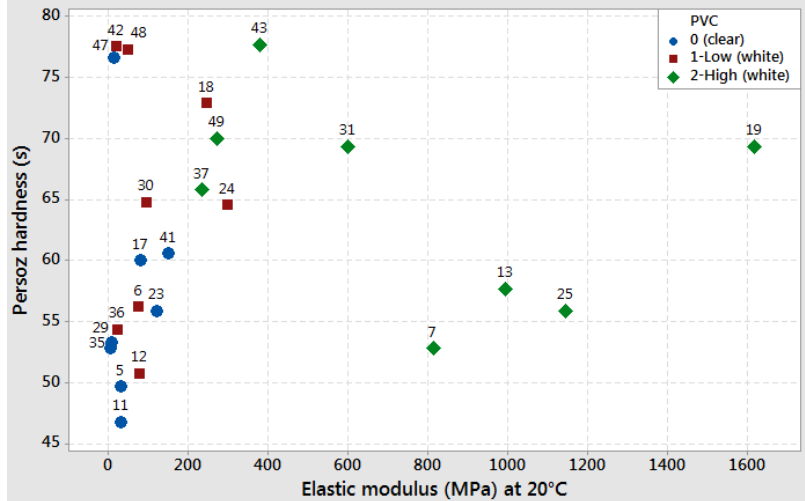
Figure 10. Relation between Persoz hardness and elastic modulus at room temperature.